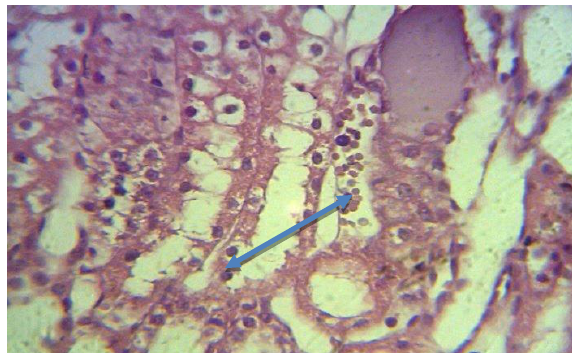
Fig. 1: Kidney of animal in T1 group 42 day post treated shows vacuolar degeneration of epithelial lining cells of renal tubules with congested blood vessels and inflammatory cells in their lumen (H and E stain 40x).